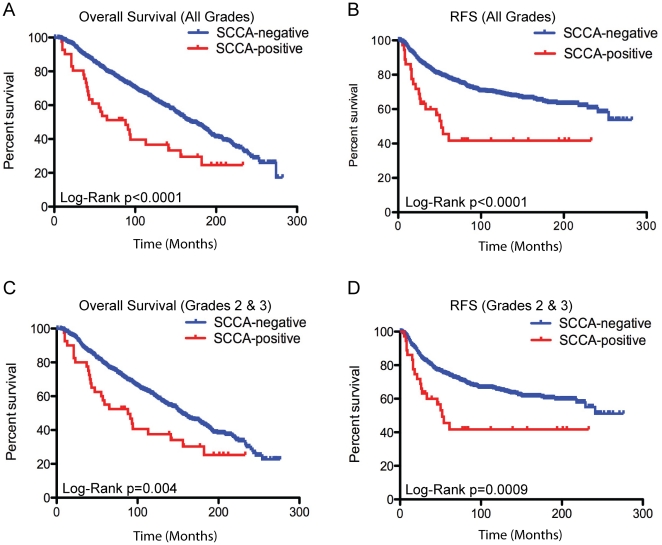
SCCA expression correlates to a decreased overall survival and recurrence-free survival.IHC was performed using the SCCA antibody FL-390 on the CDP prognostic TMAs. Kaplan-Meier survival curves for all patients (A–B) and only Grade II and Grade III patients (C–D) with SCCA-positive and negative tumors were compared for overall survival (A&C) and recurrence-free survival (B&D).